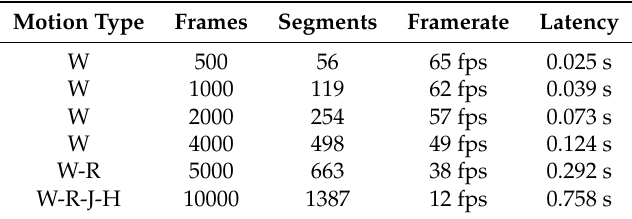
Table 2. Results obtained when evaluating the performance of the presented methodology using different motions (W: walking, R: running; J: jumping; and H: hopping) and data sizes.